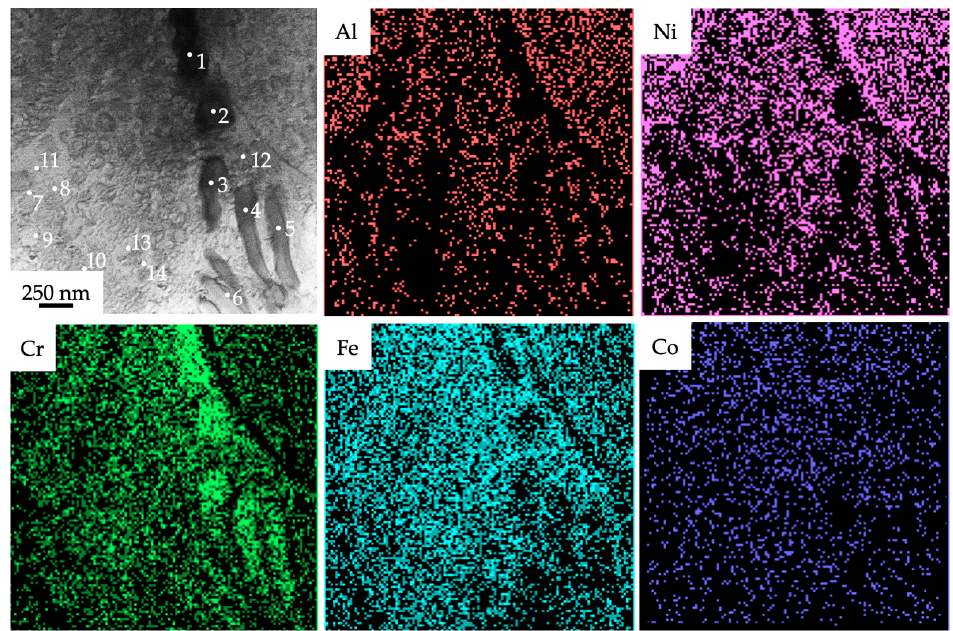
Figure 3. The TEM-EDS elemental mapping of the fabricated Al-Co-Cr-Fe-Ni HEA via wire-arc additive manufacturing. The numbers indicate areas where EDS analysis was carried out. Table 1. The TEM-EDS elemental mapping outcomes (at. %) of the foil section presented in Figure 3.